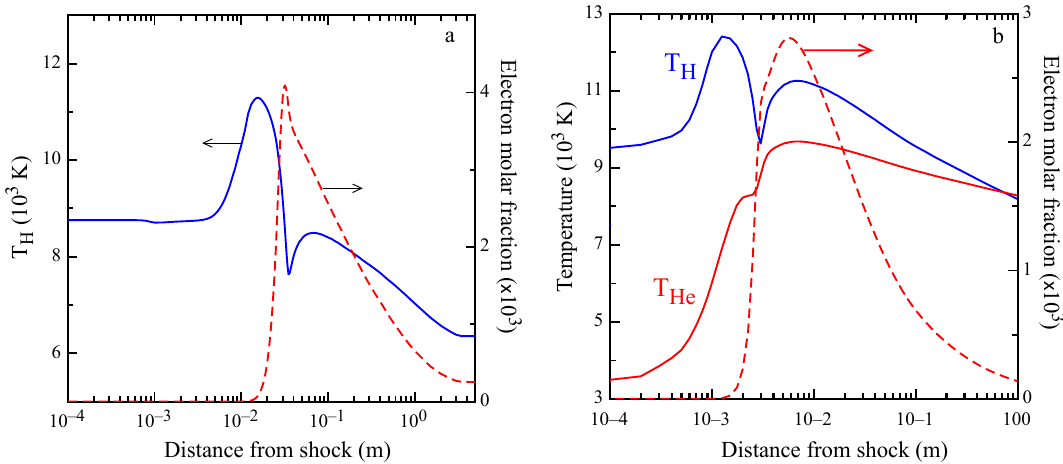
Figure 7. Atomic species internal temperatures and free electron molar fraction as a function of the position for a supersonic flow in ( a ) hydrogen (Mach 20) [29] and ( b ) helium-hydrogen (Jupiter atmosphere, Mach 31) [28] plasmas.